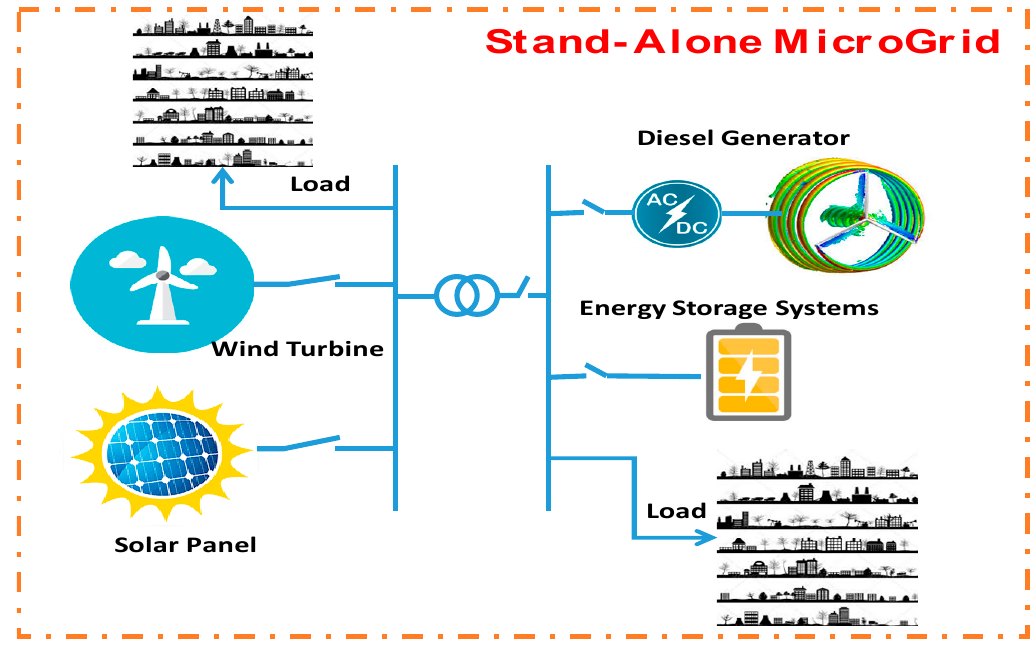
Figure 1. A general configuration of microgrids.